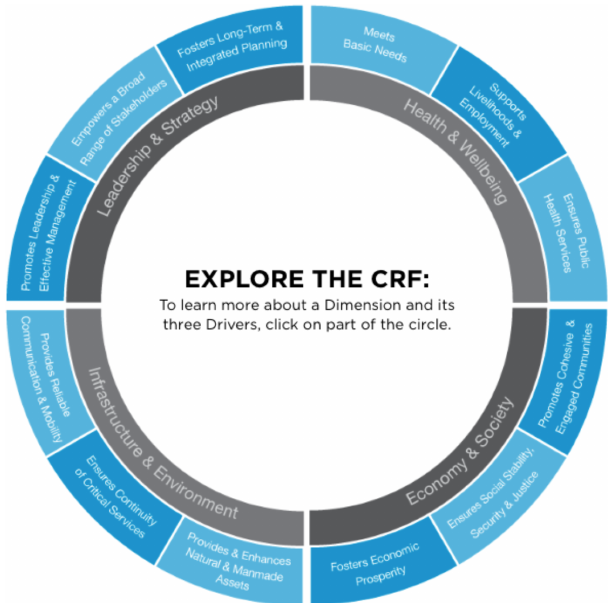
Figure 1. 100 Resilient Cities framework (taken from 100 Resilient Cities, 2015).